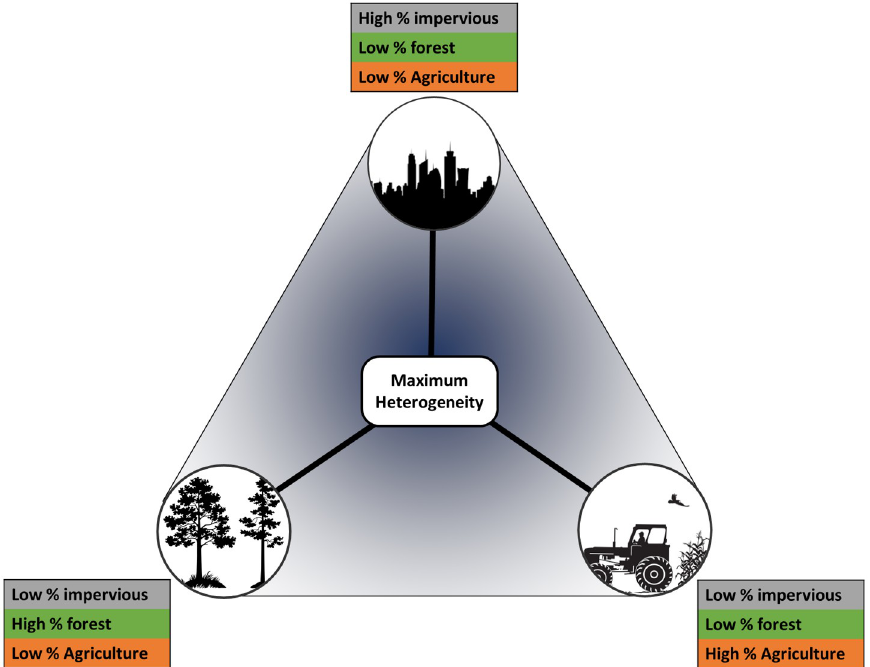
Fig 2. Conceptual diagram of multi-dimensional landscape gradient: A conceptual description of the triangular distribution captured by a multi-dimensional landscape definition that differentiates between urban, agricultural, and natural portions of the landscape along dual axes of variation. Hard and soft portions of the landscape are sorted along the vertical axis, while brown and green regions along the horizontal. This results in a multi-dimensional perspective where heterogeneity is maximized at the center of both